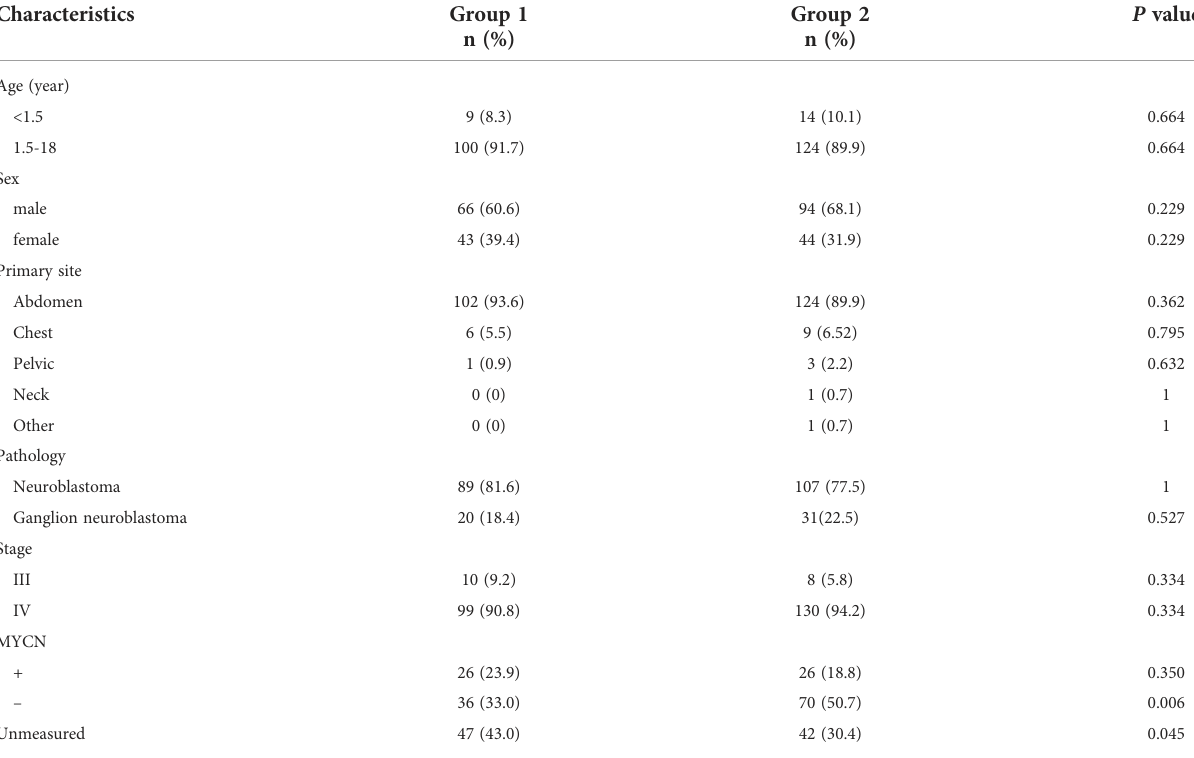
TABLE 2 Clinical characteristics of high-risk neuroblastoma